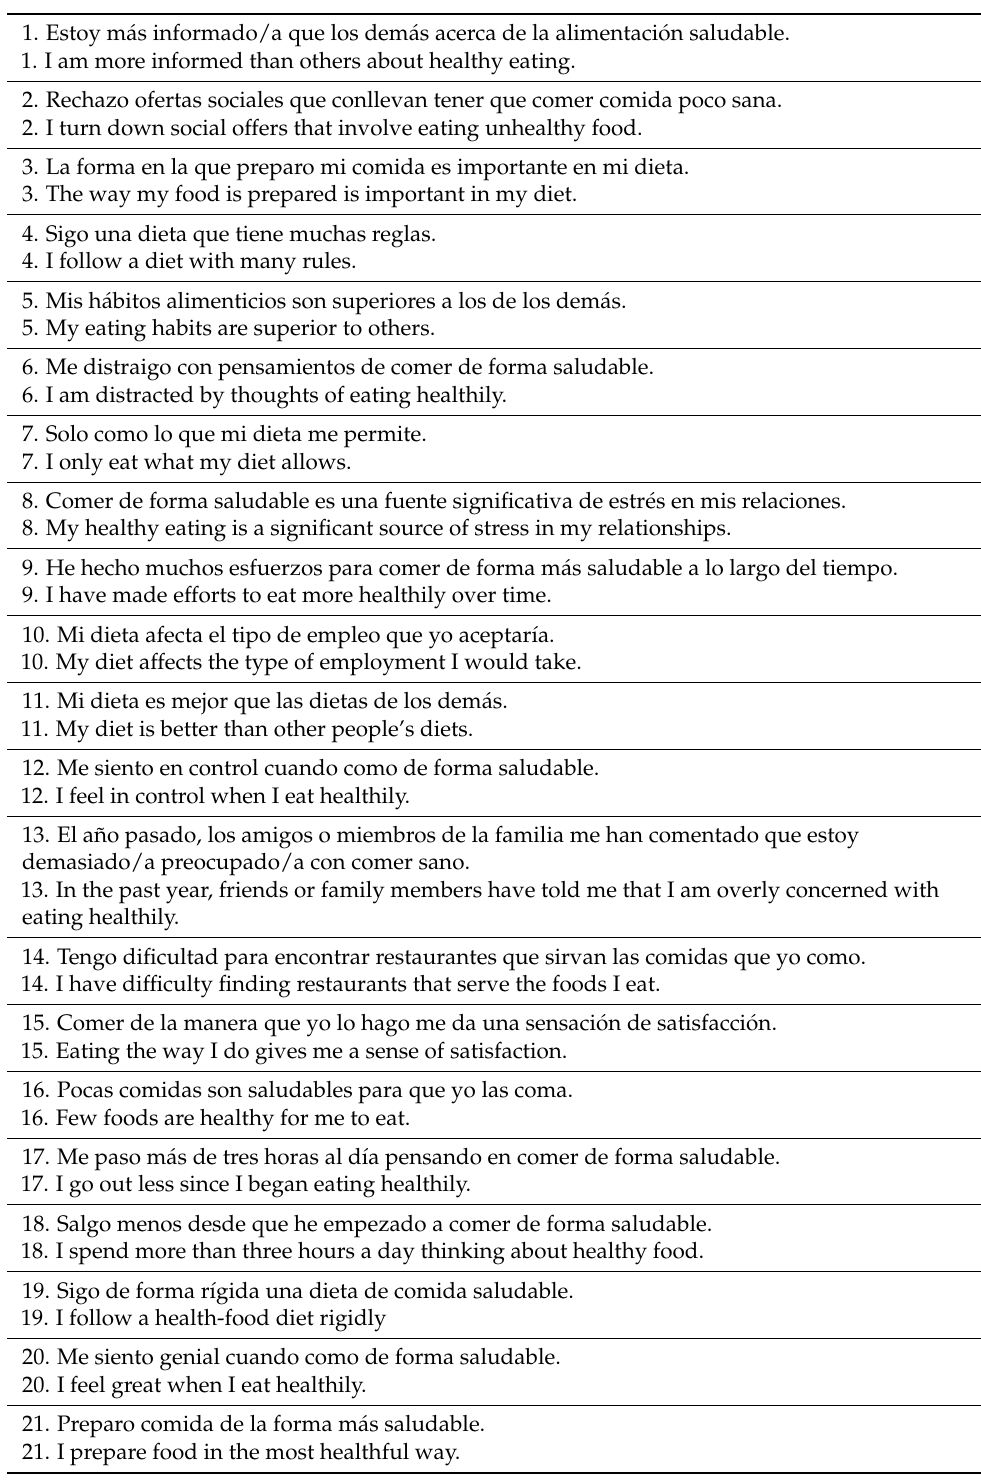
Table 1. The Spanish version of the EHQ